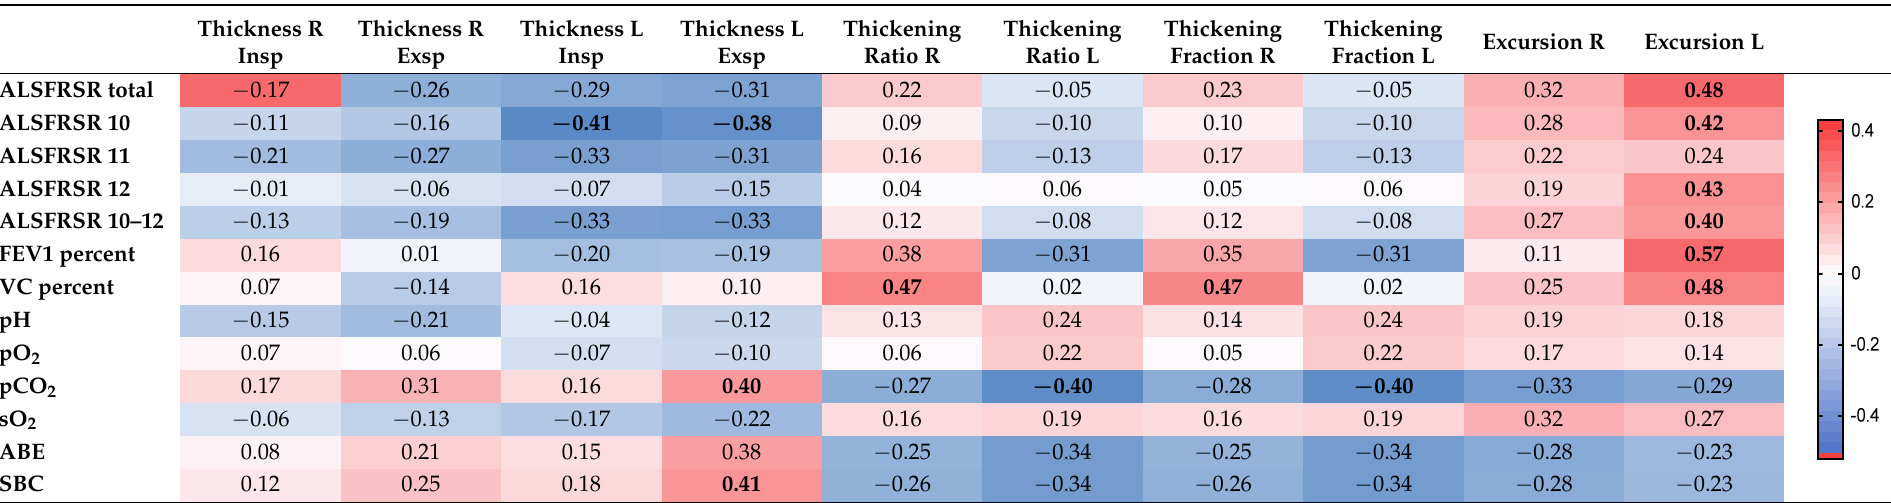
Table 3. Correlation of diaphragm B and M mode ultrasound parameters and classical measures of respiratory dysfunction in ALS